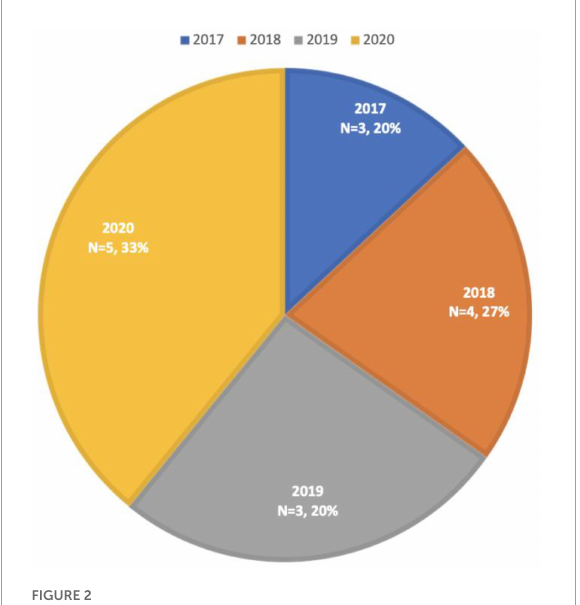
FIGURE2 Distribution of articles by year of